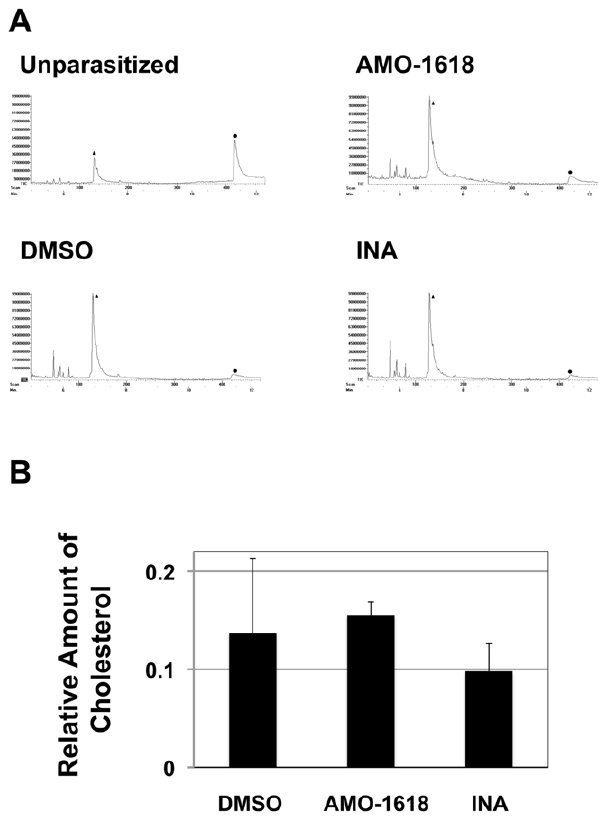
Figure 6. GC-MS analysis of isoprenoids in P.falciparuminvitro cultures. (A) Total ion chromatograms of extracts from unparasitized erythrocytes (Unparasitized), parasites treated with 0.1% DMSO, 250 m M AMO-1618, and 50 m M INA for 6 h. Triangles and circles indicate the peaks of geranylgeraniol mixed as an internal control (retention time=6.57 min) and cholesterol (11.23 min), respectively. These com- pounds were identified by direct comparison with authentic samples. (B) Quantification of cholesterol in each treated sample. Cholesterol amount was calculated from the peak areas and normalized relative to the ratio of theinternal controlgeranylgeraniol.Valuesaremeans andSD of triplicate measurements of a representative experiment. doi:10.1371/journal.pone.0032246.g006 Figure S2 Chiral separation of enantiomeric INA. Racemic form of INA was separated on Chiralcel OD column. Mobile phase: n-hexane-2-propanol (8:2, v/v), flow rate:10 ml/ min, detection: 275 nm. HPLC chromatograms of each enantio- mer are also shown. (TIF) Figure S3 Effect of gibberellin biosynthetic inhibitors on the intraerythrocytic development of P. falciparum . Asynchronized parasites were treated with 200 m M FC-907 for 24 h, 500 m M uniconazole P for 8 h, 200 m M paclobutrazol for 8 h, 50 m M INA or 1 m l/ml DMSO for 6 h. Giemsa-stained thin blood smears were prepared from each sample after the indicated treatment and examined under a microscope. Each panel shows the typical morphology of trophozoite-stage parasites in each treatment. Scale bar, 3 m m. (TIF) Figure S4 Effects of gibberellin biosynthetic inhibitors on the viability of erythrocytes to support growth of P. falciparum . Erythrocytes that had been incubated in RPMI